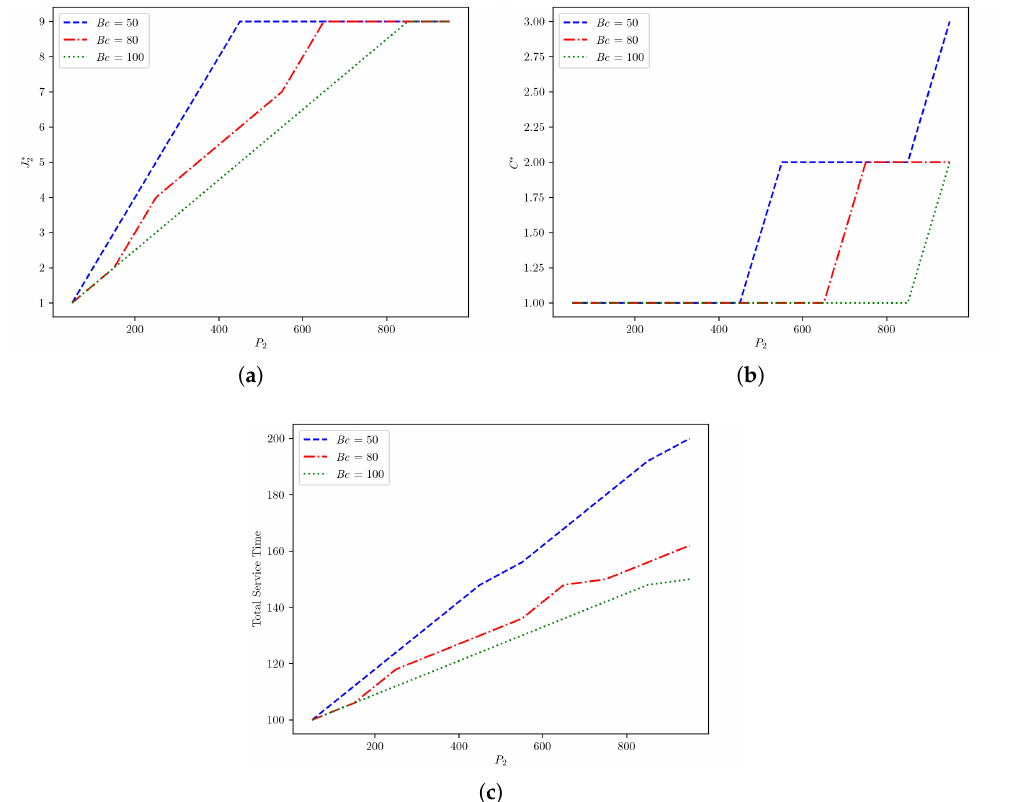
Figure 4. Impacts of change of P 2 with Bc on J ∗